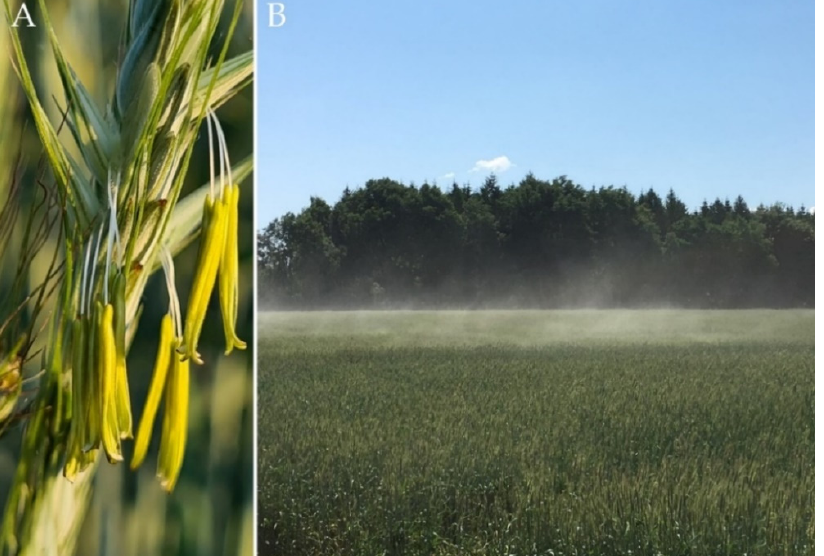
Figure 1. ( A ) Dehiscent anthers of a rye head. ( B ) Rye pollen dispersed by wind throughout a population.